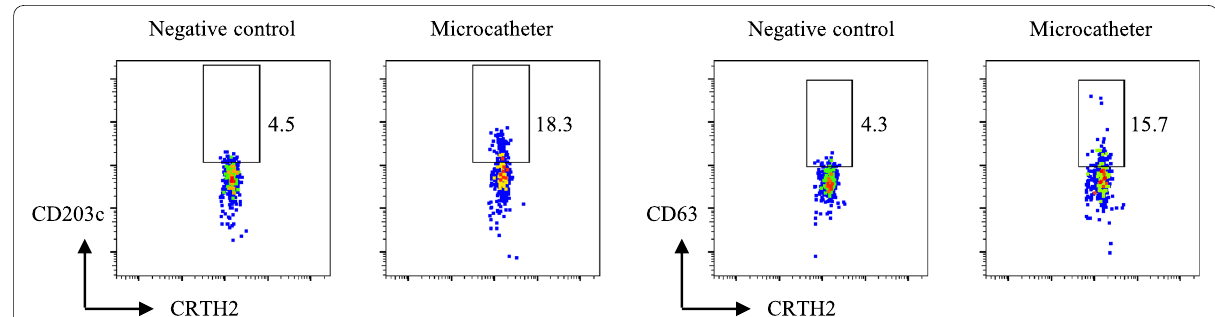
Fig. 2 Basophil activation test. The basophil population (side scatter low CD3 percentages of activated